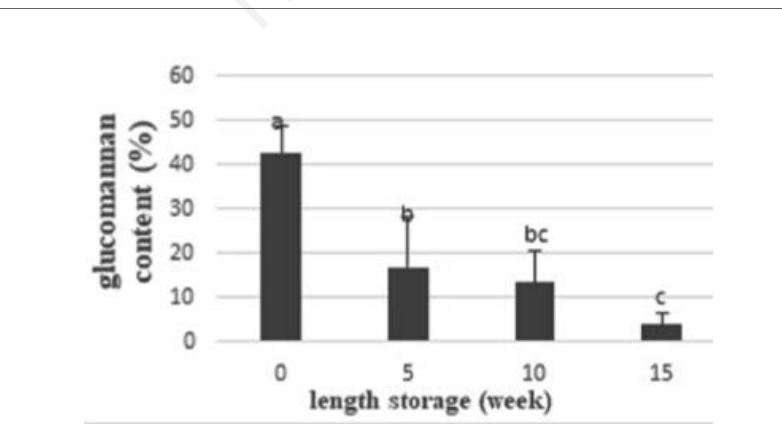
Figure 5. Glucomannan contents at four different storage times. Different letters indicate significant differences in Duncan’s test.